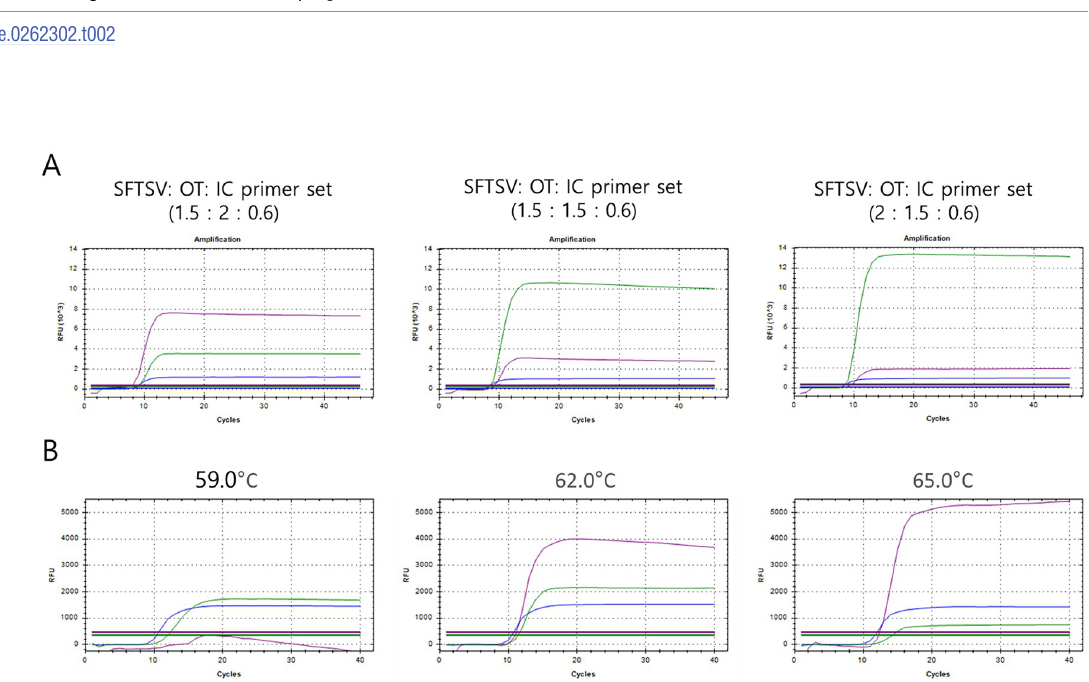
Each mean value of Ct and RFU is the average of the three LAMP assay repetitions.